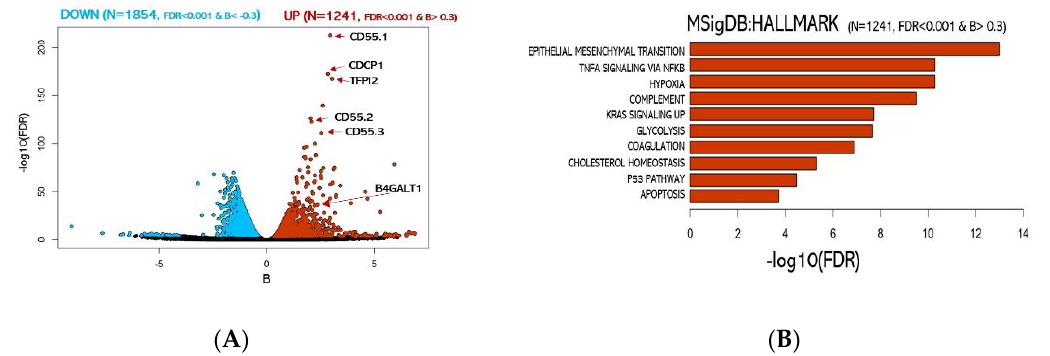
Figure 2. Analysis of 2D vs. 3D culture transcriptomes. ( A ) Volcano plot of over-expressed or under-expressed genes in 3D transcriptome vs. 2D. (blue: significantly under-expressed transcripts; red: significantly over-expressed transcripts). ( B ) Functional enrichment for upregulated genes in 3D cultures.